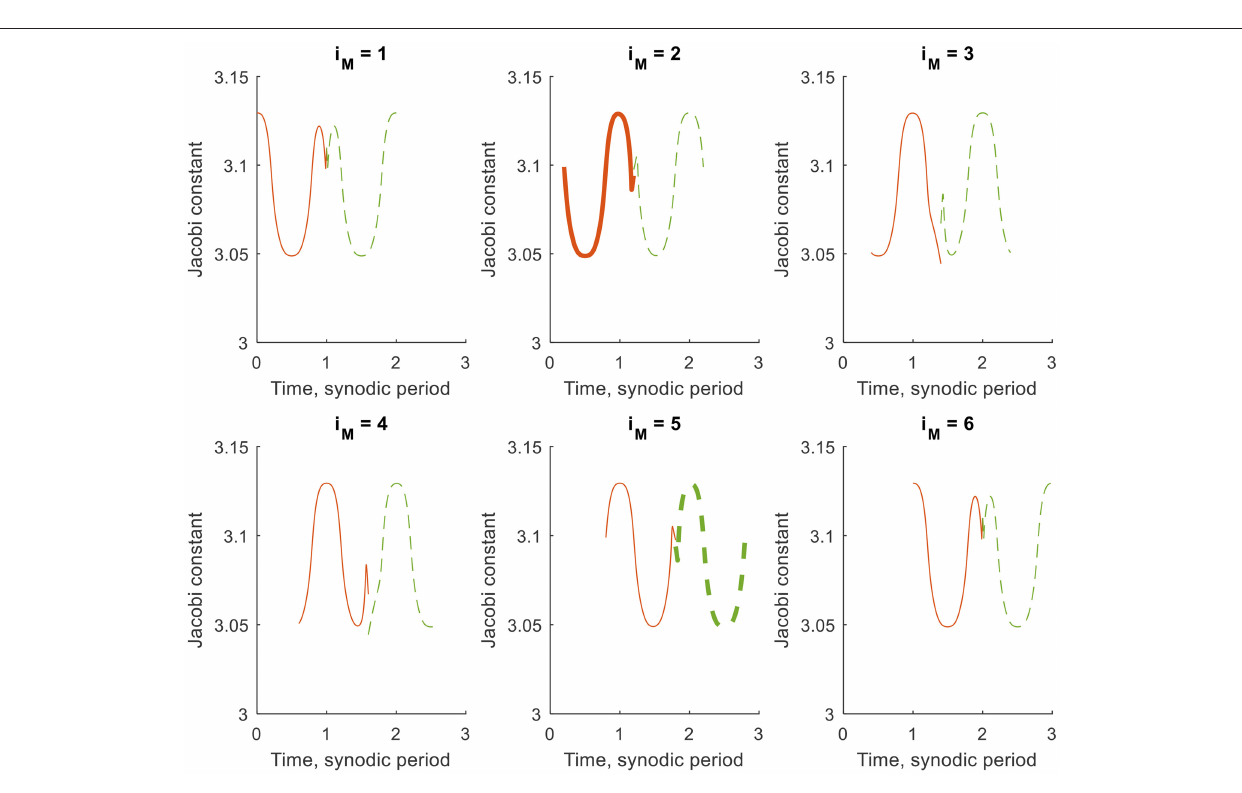
a 0, EM . Furthermore, due to the time dependent solar-sail induced acceleration, the value for C J is not constant along the orbits, see Figure 2B . Though not constant, its value is periodic and could therefore potentially provide a means to reduce the number